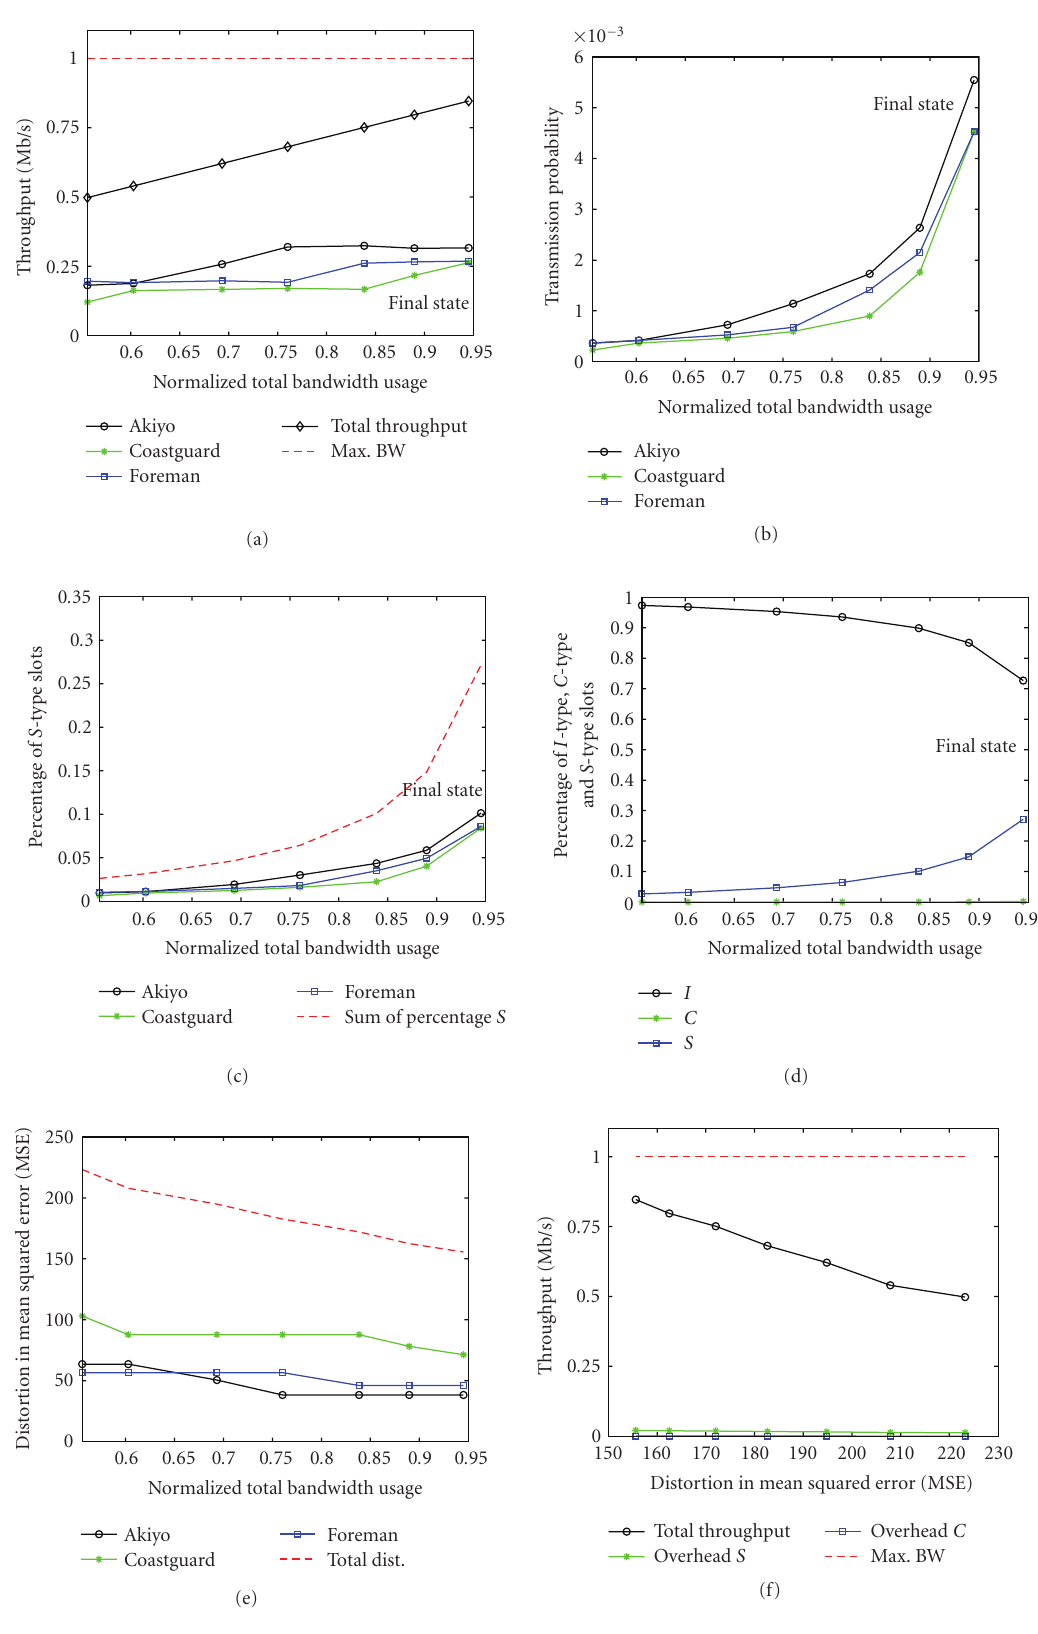
Figure 4: Performance results using the greedy algorithm. (a) Throughput, (b) transmission probability; (c) percentage of S slots, (d) percentage of I , C , and S slots, (e) distortion in MSE, (f) rate-distortion